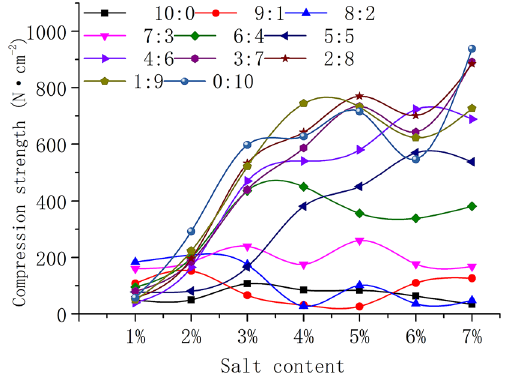
Figure 3. Compressive strength of salt crust with various salt